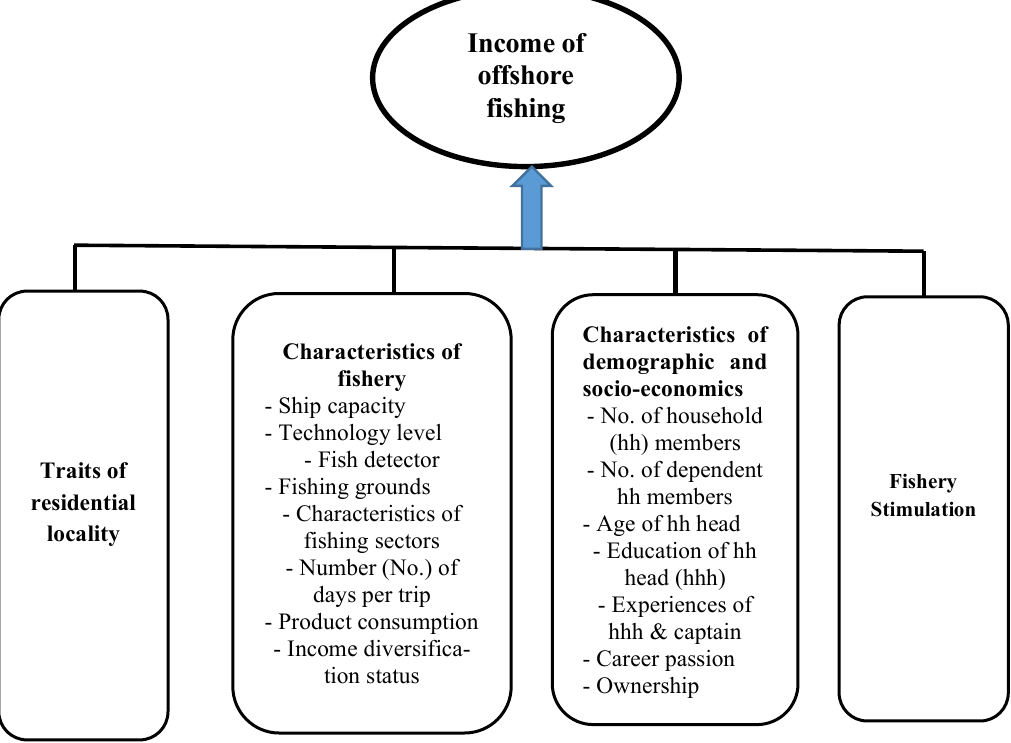
Fig. 1. Theoretical Framework of Factors Affecting the Income of Offshore Fishing